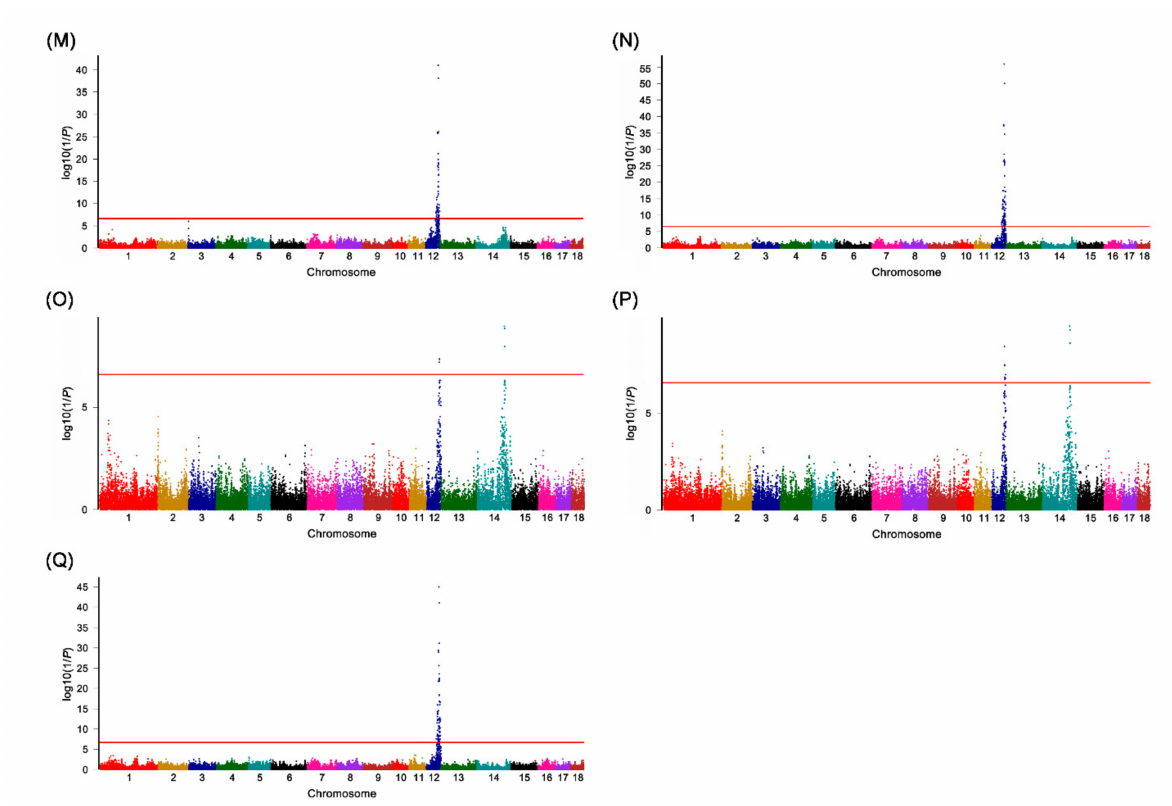
Figure 1. Manhattan plots of the GWAS for the fatty acid composition traits in the LK cross. The y-axis shows the log 10 (1/ p -value), and the x-axis shows the genomic map positions of the SNP markers on the pig autosomes. The genome- wide significance threshold value is 6.60, which equals a Bonferroni correction of 1% (represented by the red horizontal lines). ( A ) Manhattan plot for C12:0; ( B ) Manhattan plot for C16:0; ( C ) Manhattan plot for C16:1; ( D ) Manhattan plot for C17:0; ( E ) Manhattan plot for C17:1; ( F ) Manhattan plot for C18:0; ( G ) Manhattan plot for C18:1; ( H ) Manhattan plot for C18:2; ( I ) Manhattan plot for C18:3; ( J ) Manhattan plot for C20:0; ( K ) Manhattan plot for C20:1; ( L ) Manhattan plot for C20:4; ( M ) Manhattan plot for MUFAs; ( N ) Manhattan plot for PUFA; ( O ) Manhattan plot for SFA; ( P ) Manhattan plot for UFA; ( Q ) Manhattan plot for P/S ratio. The Manhattan plots show the identification of the major QTL for FA profile traits in